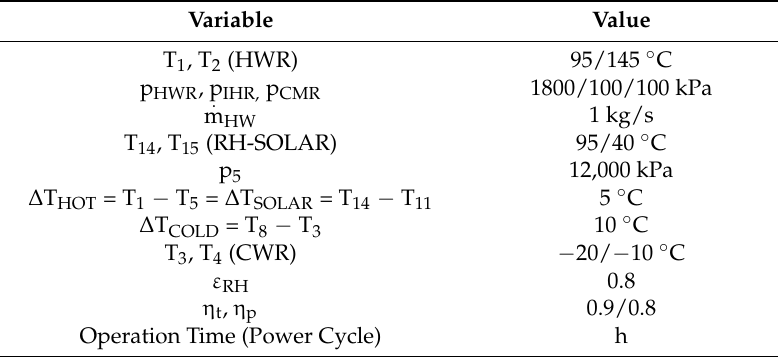
Table 2. Power cycle design operating